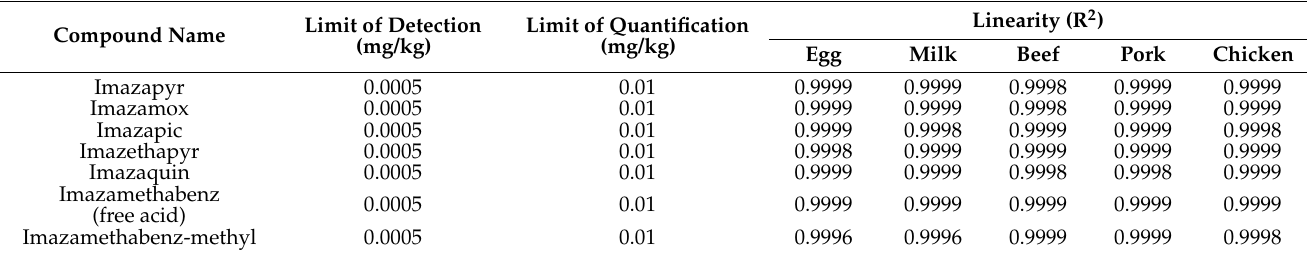
Table 5. MLOD, MLOQ, and linearity for imidazolinone herbicides to livestock products.